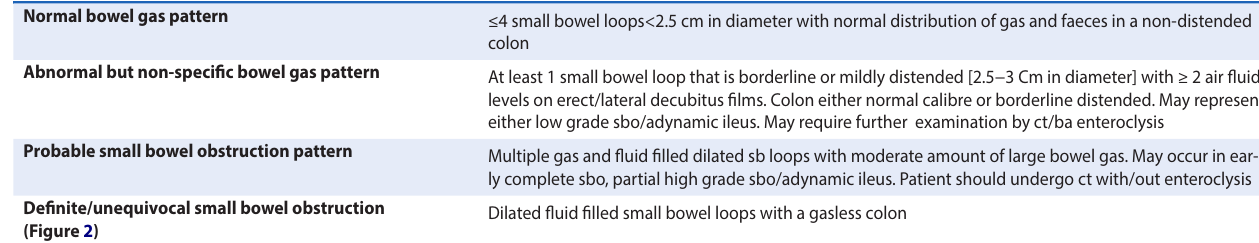
Table 1: Small bowel gas patterns Normal bowel gas pattern Abnormal but non-specific bowel gas